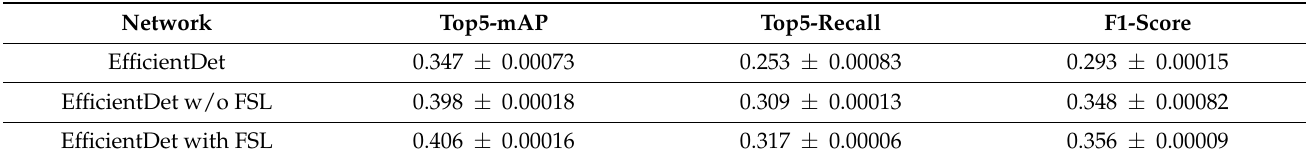
Table 3. Mean and variance of the results of five experiments as average precision, average recall, and F1